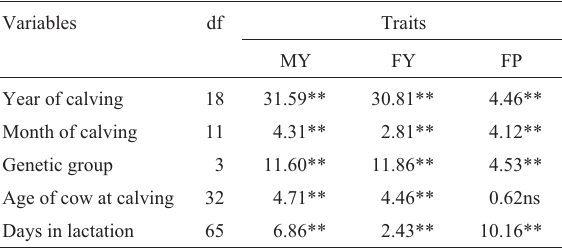
Table 1 - Summary of the variance analysis of fixed effects for milk yield (MY), fat yield (FY) and fat percentage (FP) of Holstein-Gir cows using the monthly test day